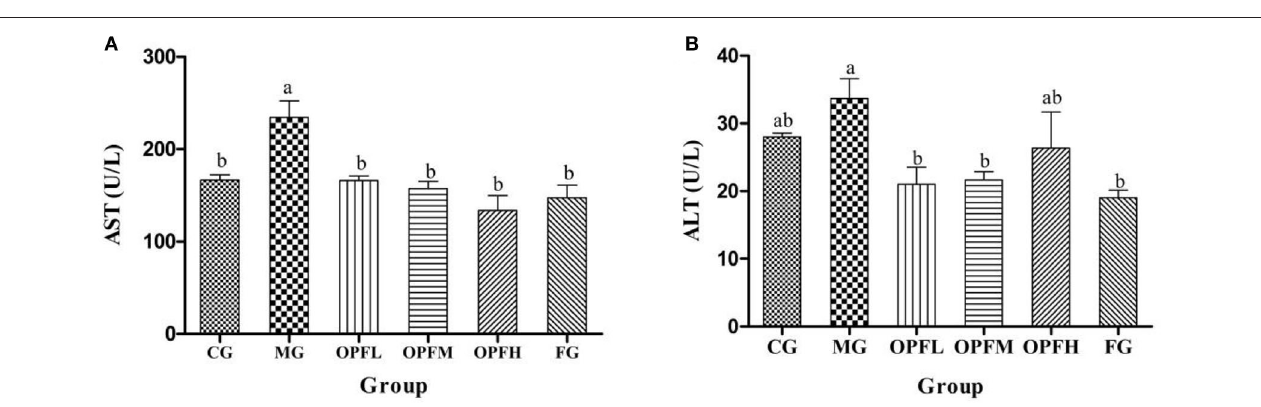
FIGURE 7 | Effects of different doses of OP-Fe 2 + and FeCl 2 on antioxidant activity in liver. (A) GSH content, (B) SOD activity, and (C) MDA content. Dates are presented as mean ± SD ( n = 10). The presence of different letters in different groups indicate a statistical difference ( p < 0.05) between them; the same letter in different groups indicates the absence of a statistical difference between these groups ( p > 0.05).